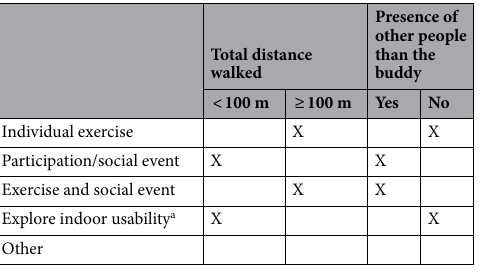
Table 1. Definitions of the categories for purpose of exoskeleton use. a Location is at home.